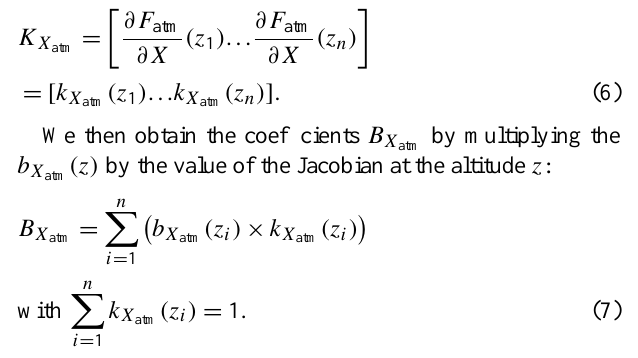
Figure 13. Variations of the HRI with HCN (top) and C 2 H 2 (bot- tom) column (molec.cm − 2 ) integrated over the 1 km-thick polluted layer in a standard modeled subtropical atmosphere from forward model simulations. The colorscale gives the altitude of the polluted layer.